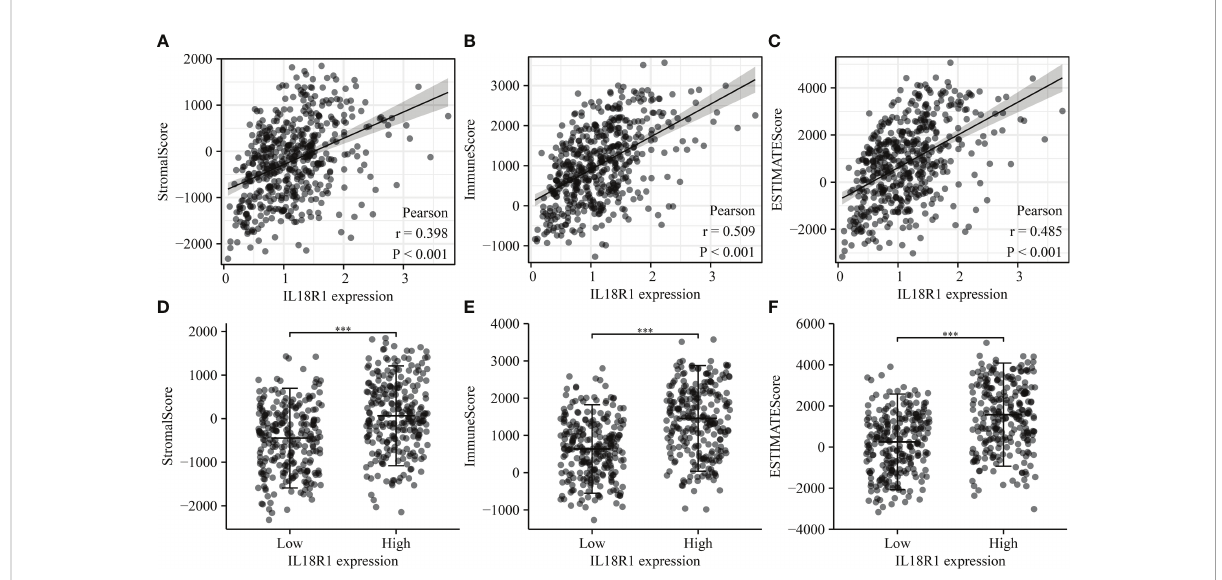
FIGURE 7 IL18R1 was signi fi cantly associated with the levels of stromal, immune, and estimate scores in LUSC. (A – C) The relationship between IL18R1 expression and stromal, immune, and estimate scores; (D – F) The levels of stromal, immune, and estimate scores in the high and low expression groups of IL18R1. LUSC, lung squamous cell carcinoma.